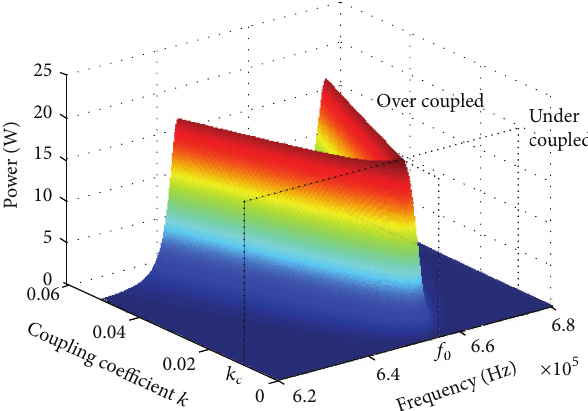
Figure 2: Output power 𝑃 𝑂 as a function of frequency and coupling coefficient 𝑘 using the parameter given in Table